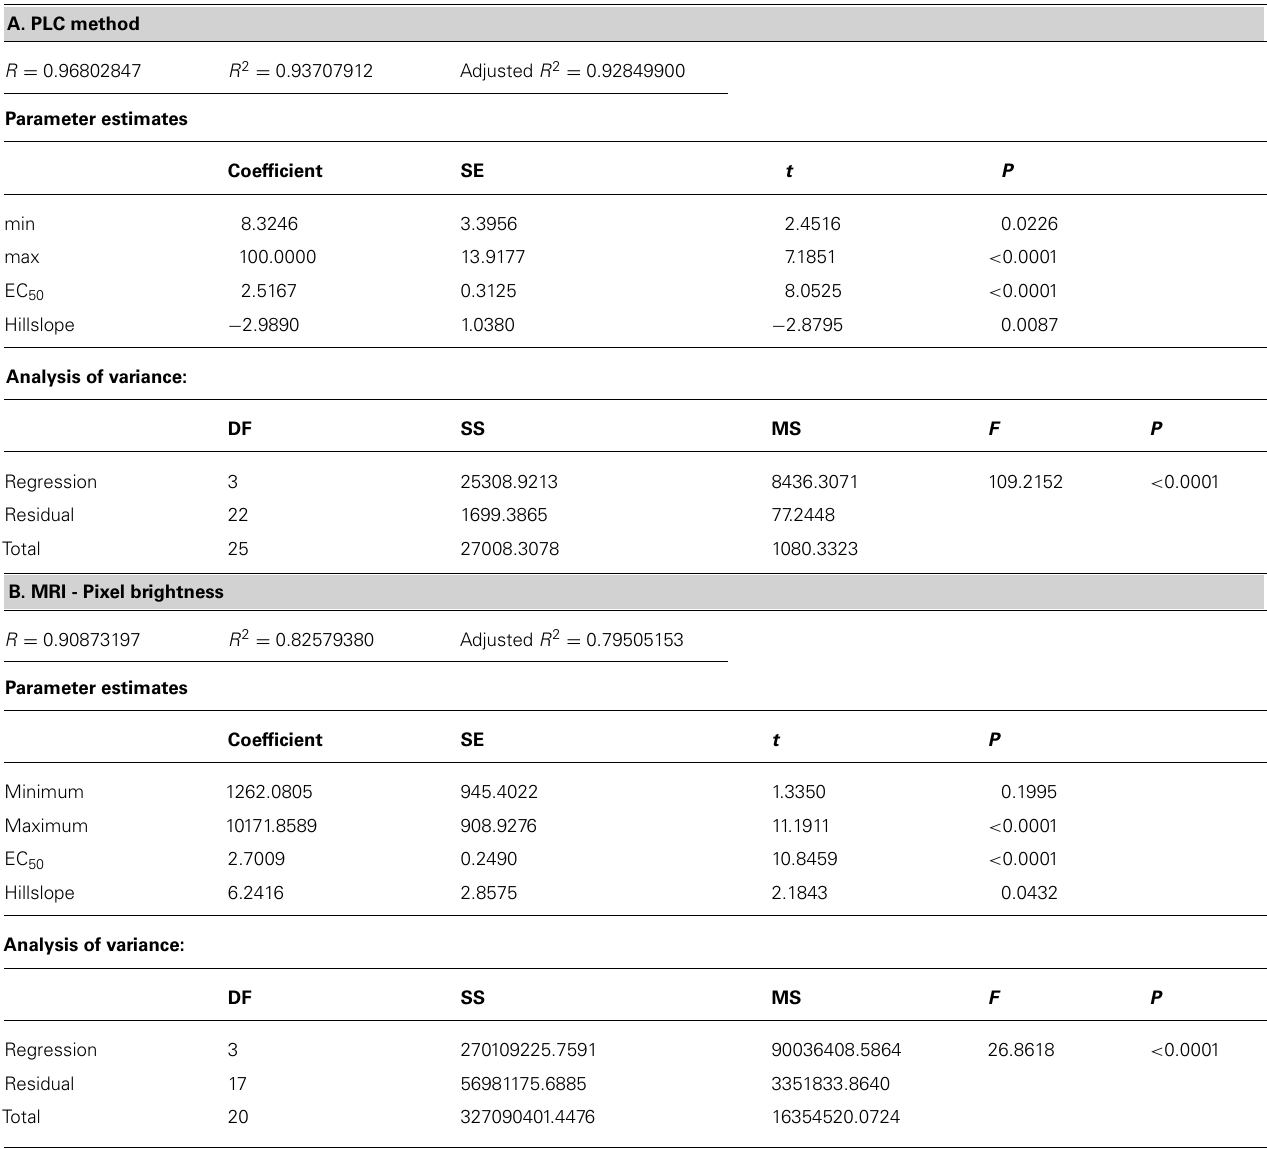
Table 1 | Statistical analysis of the fit of dose–response curve (Figure 1) (A) PLC = min PLC + (max PLC − min PLC )/[1 + (C/EC 50 ) slope )] to PLC and (B) pixel brightness (pb) from MRI {pb = min pb + (max pb − min pb )/[1 + (C/EC 50 ) slope